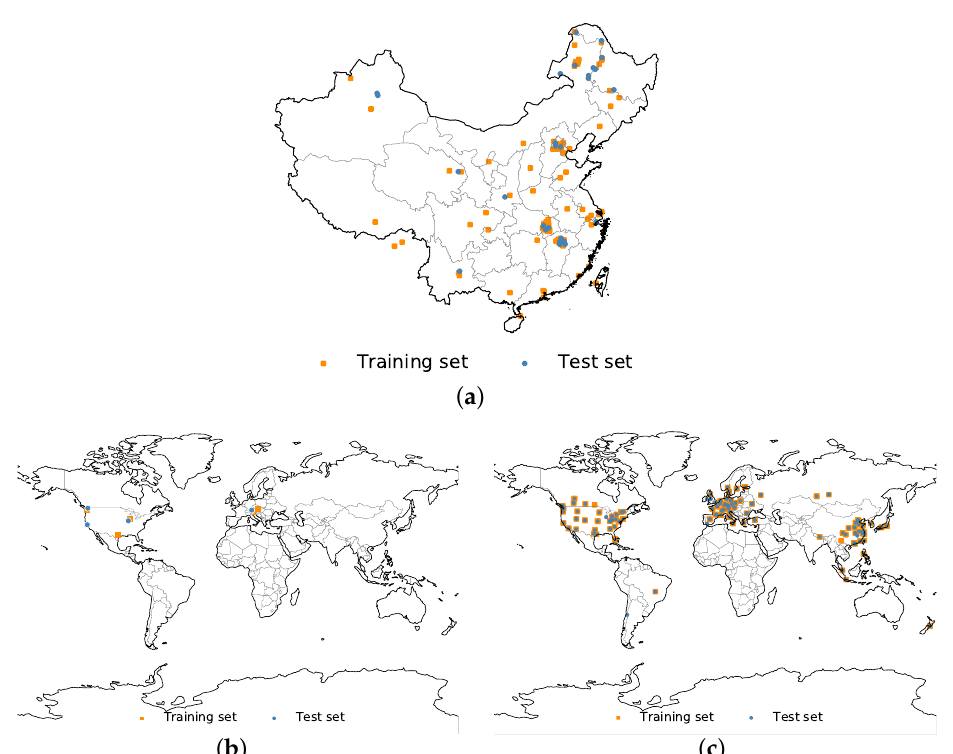
Figure 3. Distributions of the datasets: ( a ) distribution of the image tiles in the GID dataset [38] around China. Each point in this figure is one image tile. It contains 150 tiles in total. The training and test data are similarly distributed; ( b ) spatial distribution of the Inria building dataset [6]. Different from the GID dataset, each point in this figure is one city with 36 image tiles. There are altogether 10 cities containing 360 image tiles; ( c ) spatial distribution of the image tiles in the DREAM-B dataset. Each point in this figure is an image tile. There are 626 tiles in this